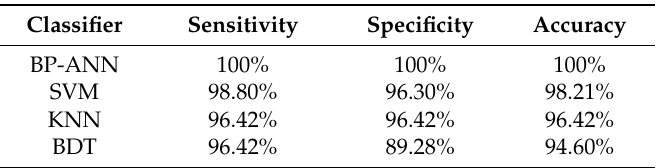
Table 10. Comparison of the classification algorithms using performance metrics when the range data are used as the input features (4 patients and 12 normal